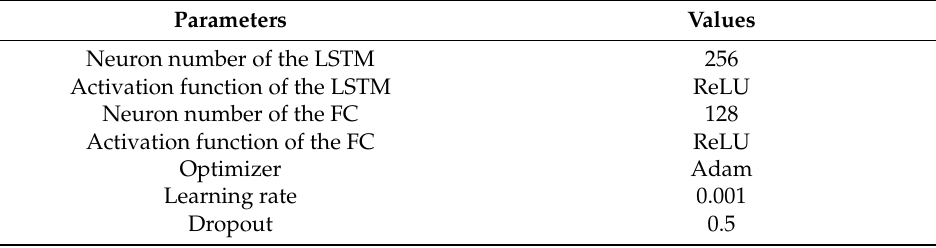
Table 4. Parameters settings for the Actor network.